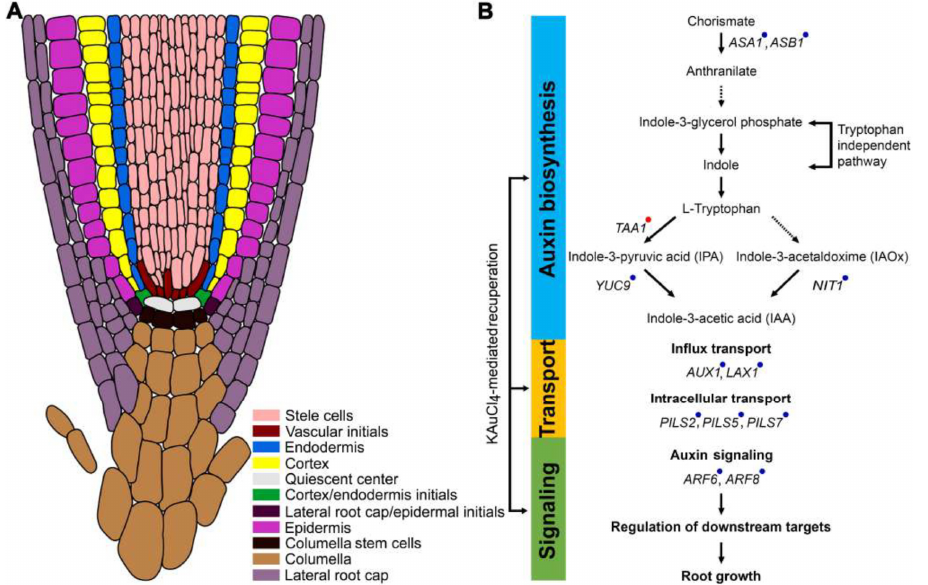
Figure 10. A model depicting the differential effects of KAuCl 4 on the genes involved in the biosyn- thesis, transport, and signaling of auxin in the root. ( A ) A schematic diagram of the primary root tip with 11 specific cell types indicated with color codes. ASA1 , ASB1 , NIT1 , AUX1 , PILS2 , PILS7 , ARF6 , and ARF8 are expressed in all the cell types. However, TAA1 (vascular initials, quiescent center, cortex /endodermal initials, lateral root cap/epidermal initials, and columella stem cells), YUC9 (vas- cular initials, quiescent center, cortex/endodermal initials, lateral root cap/epidermal initials, colu- mella stem cells, columella, and lateral root cap), LAX1 (stele cells), and PILS5 (stele cells, endo- dermis, cortex, quiescent center, and epidermis) show expressions in only some of the specific cell types. ( B ) Blue and red dots on the genes indicate their suppression and induction, respectively, in response to NR.IAA treatment and their subsequent recuperation upon treatment with NR.IAA.KAuCl 4 . Solid arrows indicate pathways in which the genes, enzymes, or intermediates are known, and dashed arrows indicate pathways that are not well-defined.